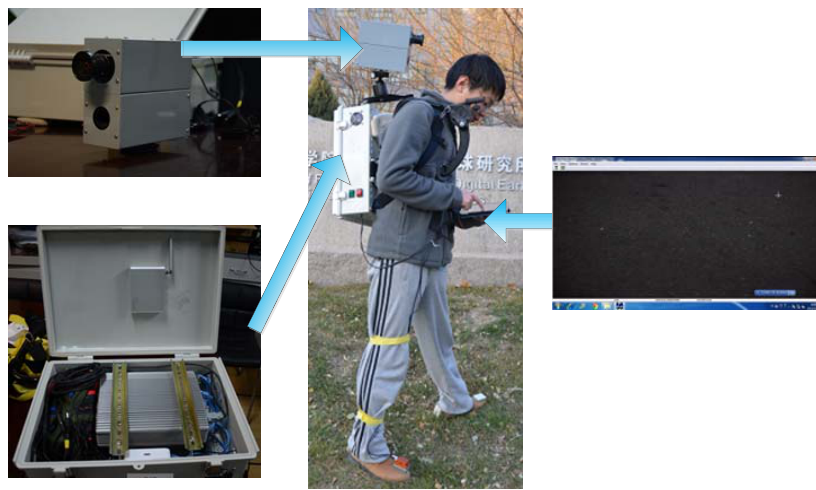
Figure 1. The hardware scheme for the astronaut navigation